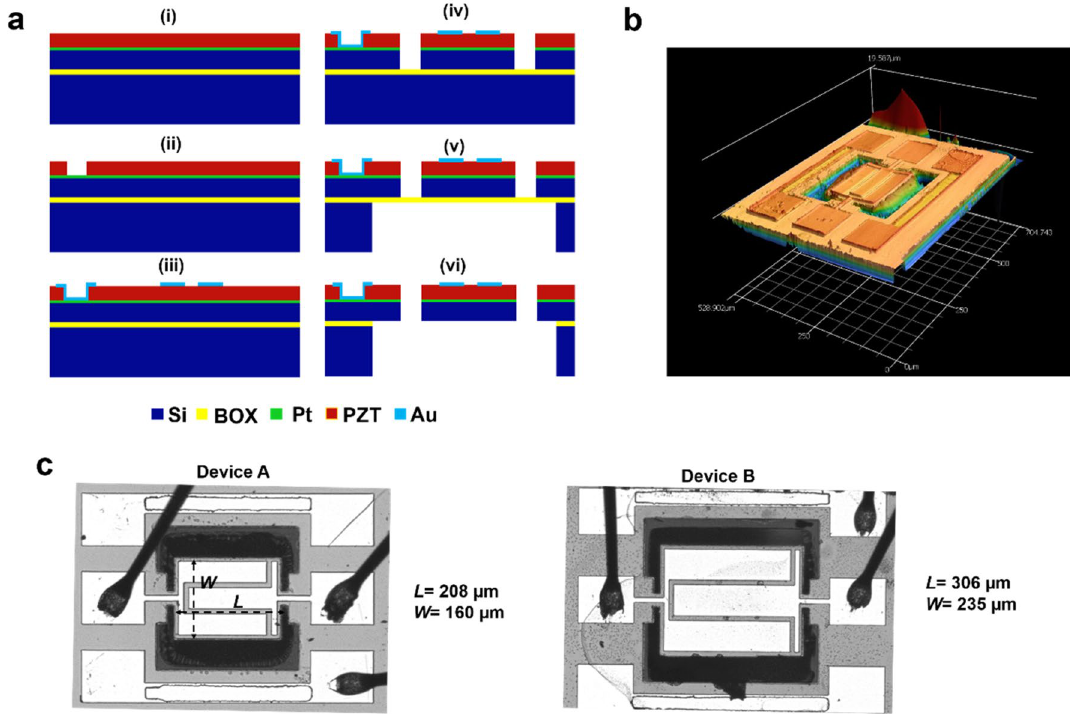
Figure 6. Device fabrication. ( a ) Fabrication flow of the PZT TPoS MEMS resonator. (i) Incoming PZT thin film on SOI wafer. (ii) First mask: Pattern PZT. (iii) Second mask: Pattern top electrode. (iv) Third mask: Pattern ( c ) Optical microscope images of Devices A and B with their dimensions